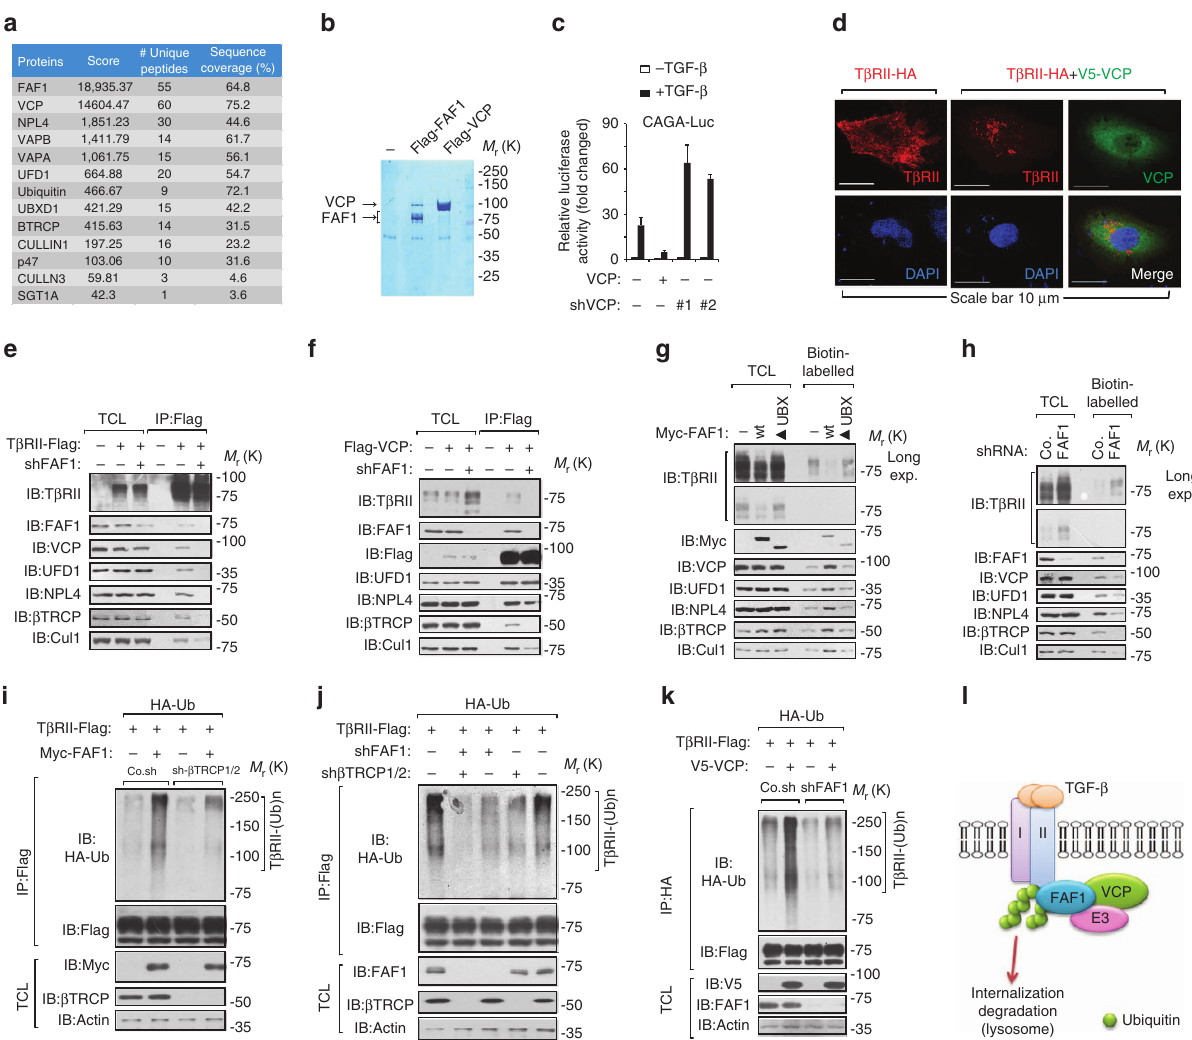
Figure 3 | FAF1 recruits VCP/ b TRCP to target T b RII for polyubiquitination. ( a ) Mass spectrometry studies of anti-Flag-FAF1 immunoprecipitants revealed FAF1-binding partners. ( b ) FAF1 bound to VCP at a ratio close to 1:1. ( c ) The CAGA 12 -Luc SMAD-dependent transcriptional response of HEK293T cells expressing VCP or VCP shRNA (#1 and #2) and treated with TGF- b (2.5ngml (cid:2) 1 ) overnight is shown. The data are presented as the mean ± s.d. of three independent sets of experiments. ( d ) Immunofluorescence and 4, 6-diamidino-2-phenylindole (DAPI) staining of HeLa cells transfected with T b RII-HA or T b RII-HA with V5-VCP plasmids. Scale bar, 10 m m. ( e , f ) HEK293T cells were transfected with T b RII-Flag ( e ) or Flag-VCP ( f ) and with FAF1 depletion or not, as indicated. Cells were collected for immunoprecipitation (IP) and immunoblot (IB) analysis; 5% of the total cell lysate was loaded as an input. ( g , h ) MDA-MB-231 cells expressing Myc-FAF1 wt/UBX-deletion mutant ( m UBX) ( g ) or infected with FAF1 shRNA as indicated ( h ) were harvested for biotinylation and immunoblot (IB) analysis. Co., control non-targeting shRNA. ( i ) HA-Ub stably expressing HEK293Tcells were transfected with T b RII- Flag along with Myc-FAF1 and were infected with control (Co.sh) or b TRCP shRNA lentivirus as indicated. The cells were then collected for IP and IB analysis. ( j ) HA-Ub stably expressing HEK293Tcells were transfected with T b RII-Flag and infected with b TRCP1/2 shRNA and/or FAF1 shRNA lentivirus as indicated. Cells were then collected for IP and IB analysis. ( k ) HA-Ub stably expressed HEK293Tcells were transfected with T b RII-Flag and VCP, and were infected with FAF1 shRNA lentivirus as indicated. Cells were then collected for IP and IB analysis. ( l ) Working model of how FAF1 mediates T b RII polyubiquitylation and turnover via lysosomal mediated